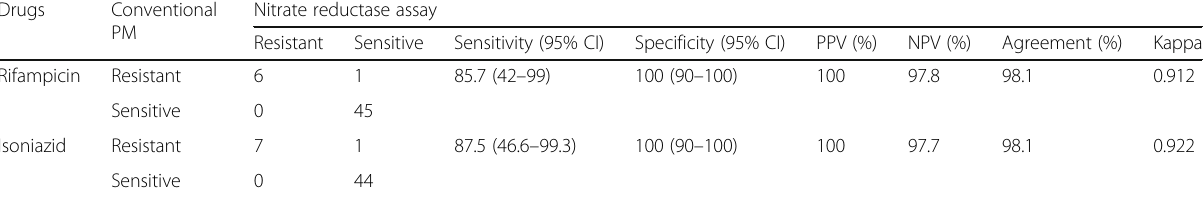
Table 1 Comparison of nitrate reductase assay results with conventional proportion method